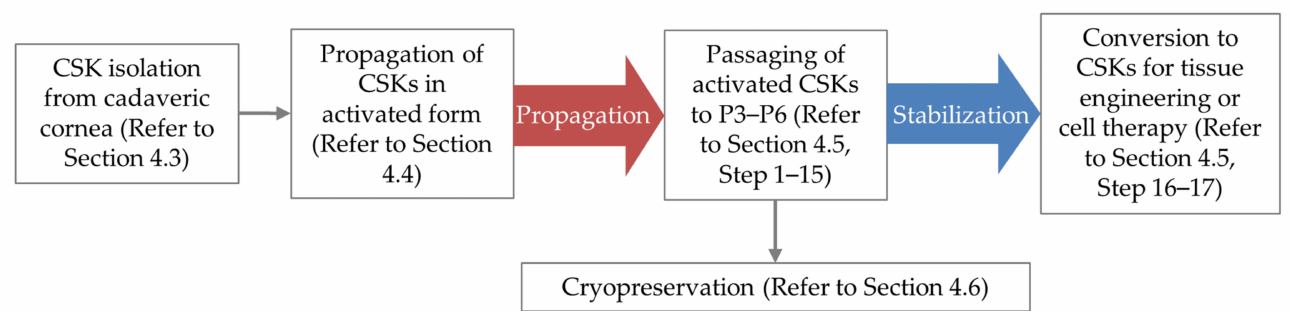
Figure 1. Overview of human corneal stromal keratocyte (CSK) cell culture procedure. In the propagation phase, the culture medium is supplemented with 0.5% fetal bovine serum (FBS) to support the proliferation of CSKs, which are otherwise quiescent. In the stabilization phase, the FBS is removed from the culture medium to allow the cells to regain bona fide CSK